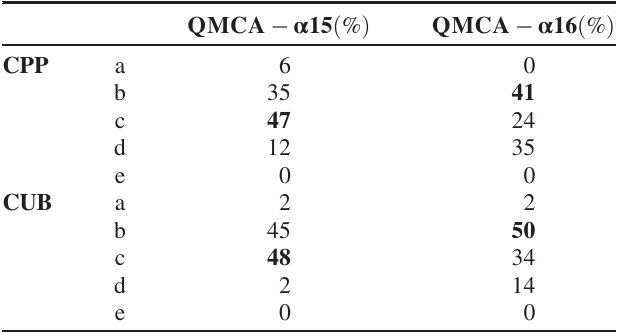
TABLE IV. Student responses to Q15 and Q16 on the alpha study. The bold numbers represent the correct